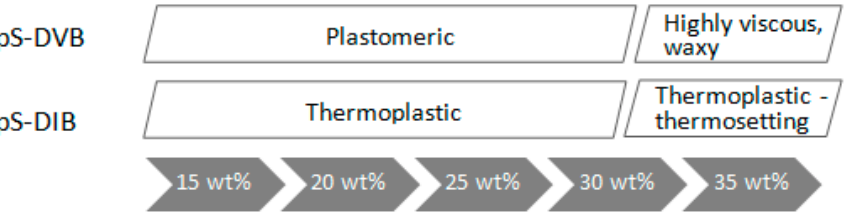
Figure 16. Scheme of the dependence between polymer type and incorporated monomer content.